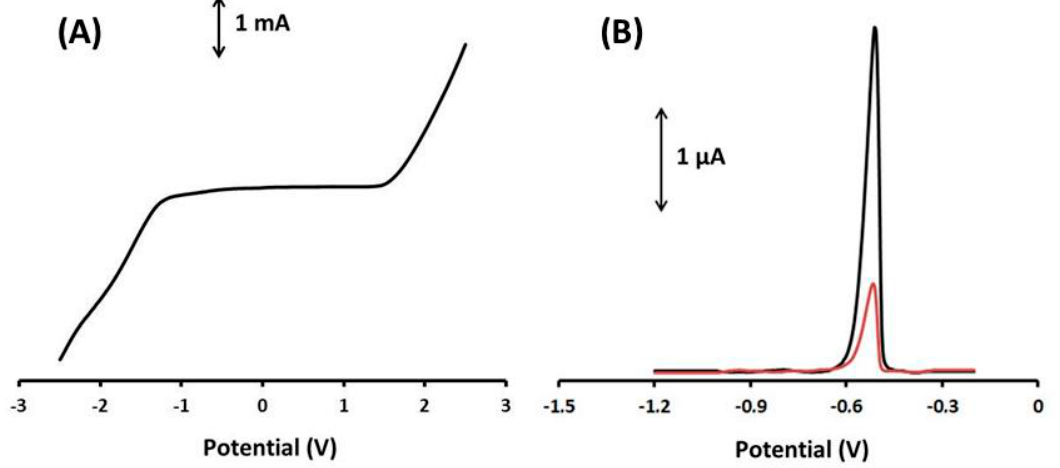
Figure 2. ( A ) LS voltammograms of the 3D-printed Ca-MOF device in 0.1 mol L − 1 acetate buffer (pH 4.5). Scan rate, 50 mV s − 1 . ( B ) DP voltammogram of 20 µg L − 1 of Pb(II) (black line) obtained with the modified GPE with Ca-MOF and DP voltammograms of 20 µg L − 1 of Pb(II) (red line) obtained with the bare GPE in 0.1 mol L − 1 acetate buffer (pH 4.5).